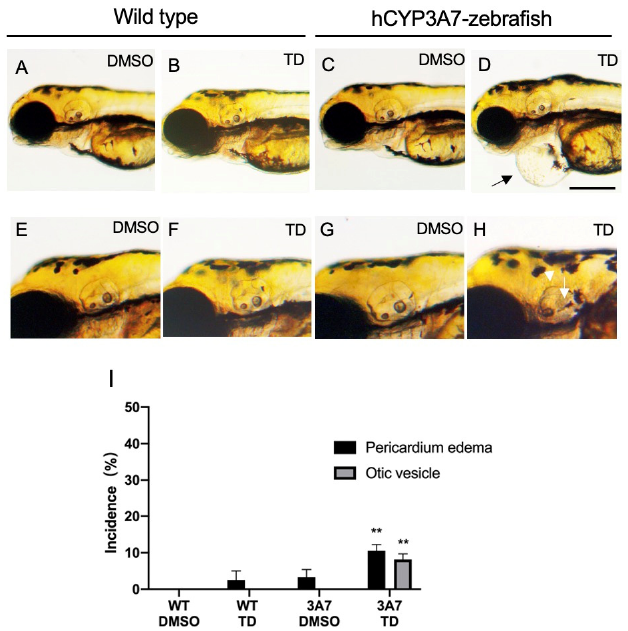
Figure 3. Effects of thalidomide on pericardial edema and otic vesicles of hCYP3A7-expressing zebrafish. Embryos/larvae of wild-type (WT) zebrafish ( A , B , E , F ) and hCYP3A7-expressing zebrafish (3A7) ( C , D , G , H ) were exposed to 200 µM thalidomide (TD) or 0.02% DMSO as a vehicle from 17 hpf to 72 hpf. The arrow in D indicates severe pericardial edema. The arrow and arrowhead show loss of a large otolith (saccule) and round otic vesicle, respectively. Scale bar = 200 µm. Summarized data are presented as a graph in I ( n = 4, 8–26 zebrafish for each case). ** p < 0.01.